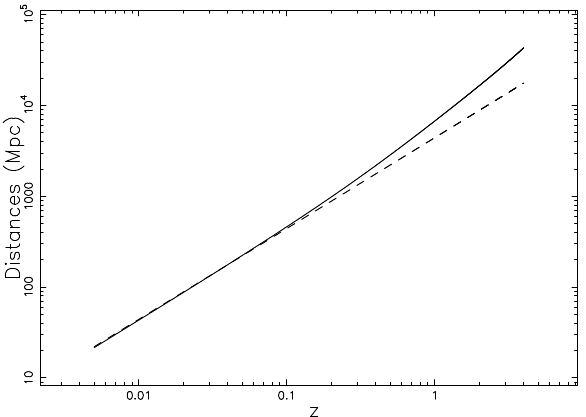
Figure 1. The distances that are adopted are: the luminosity dis- tance, D L , in Λ CDM (full line); and the pseudo-Euclidean cosmology distance (dashed